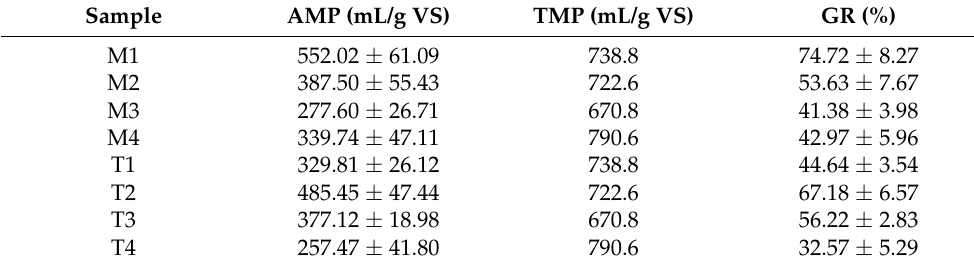
Table 3. Gasification rate (GR) and actual methane production (AMP) under mesophilic conditions and thermophilic conditions (note: the data were the mean of three repetitions with standard